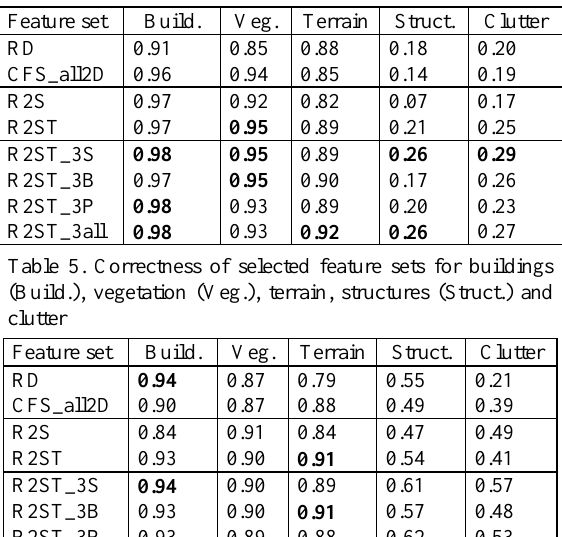
Table 4. Overall Accuracies obtained by the various feature sets for the different classification problems. N = the number of features per set.